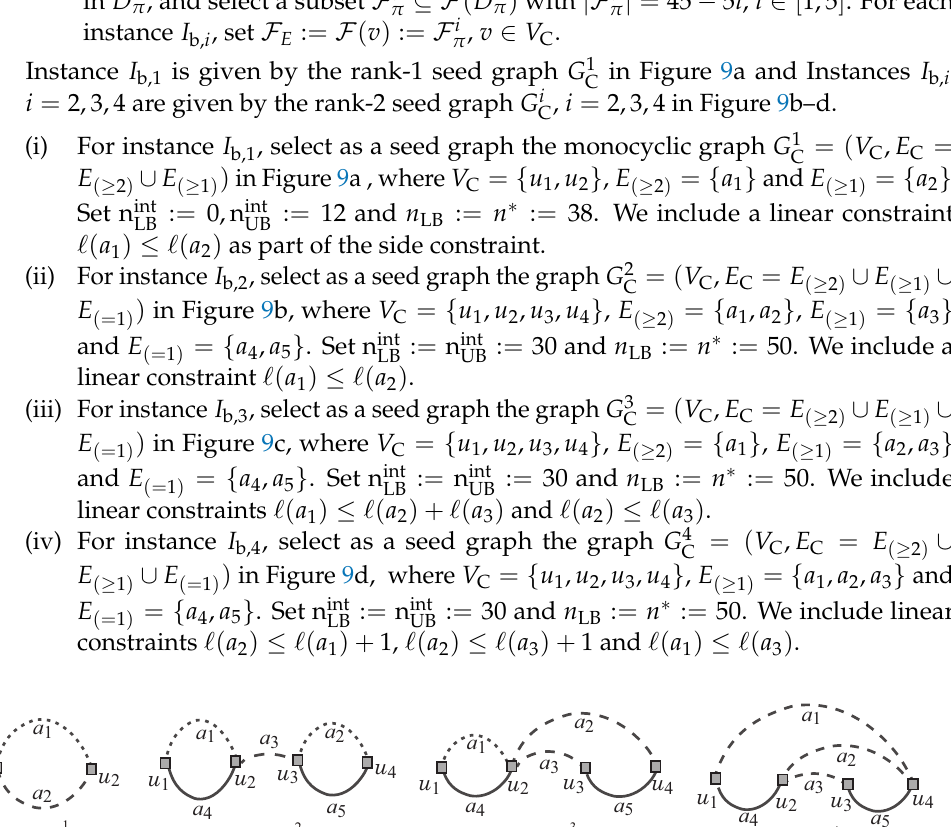
; ( b ) A rank-2 cyclic graph G 2 C with two disjoint cycles sharing a vertex; C